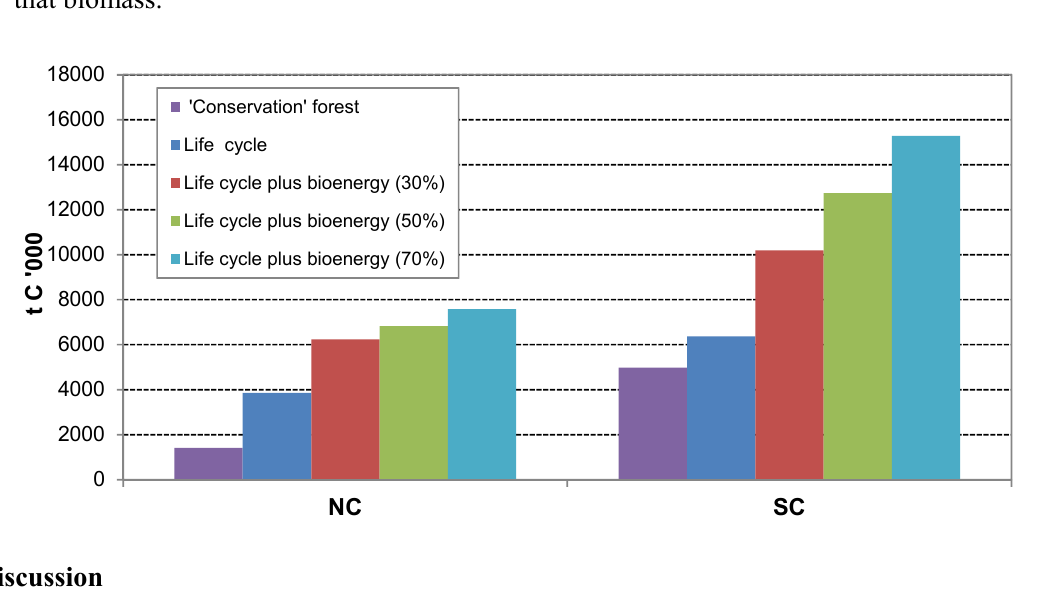
compared with “ conservation ” RES